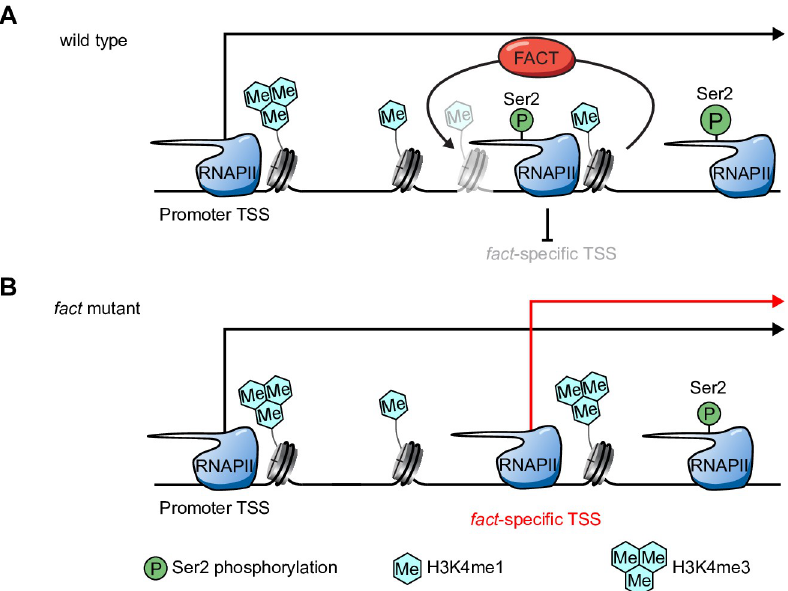
Fig 8. Cartoon summarizing FACT-dependent chromatin repression of intragenic TSSs in Arabidopsis . (A) In wild type Arabidopsis , RNAPII initiates transcription from canonical promoters of genes containing fact -specific TSS. Specific histone signatures such as H3K4me3 (blue tri-hexagon) are associated with TSSs at promoters, while RNAPII CTD Ser2 phosphorylation (green circle) and H3K4me1 (blue hexagon) are associated with RNAPII elongation zones. Repressed intragenic fact -specific TSSs are enriched for H3K4me1 in their repressed state. (B) fact -specific TSSs initiate transcription (red arrow) in fact mutants. Only a subset of intragenic sites marked with H3K4me1 represents fact -specific TSSs, indicated by a H3K4me1-marked nucleosome at a position without evidence for transcriptional initiation in fact mutants. Activation of fact -specific intragenic TSSs correlates with reduced H3K4me1 level and an increase of the H3K4me3 promoter